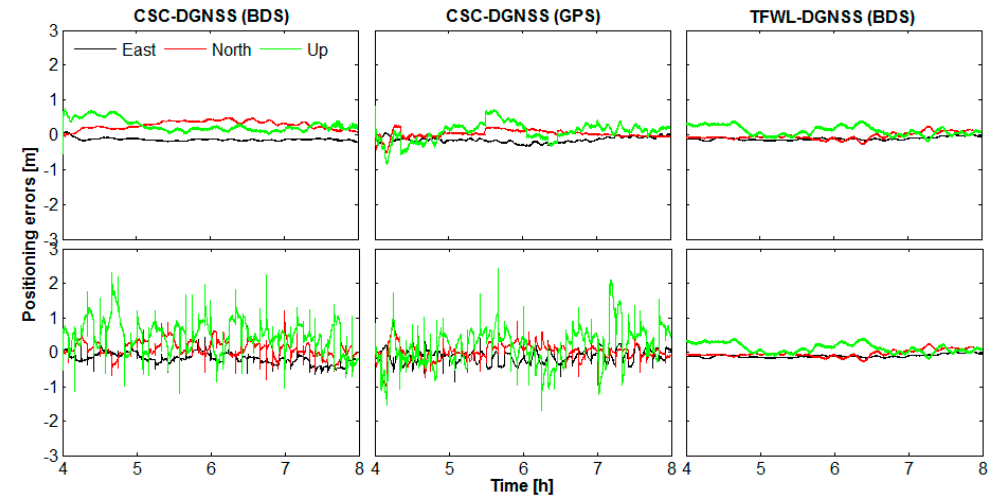
Figure 8. Positioning errors of the CSC-DGNSS and TFWL-DGNSS in both the signal interruption case and no signal interruption case for baseline WHCD-WHHP. The top panels are for the results without simulated signal interruption, whereas the bottom panels are for the results with simulated signal interruption.